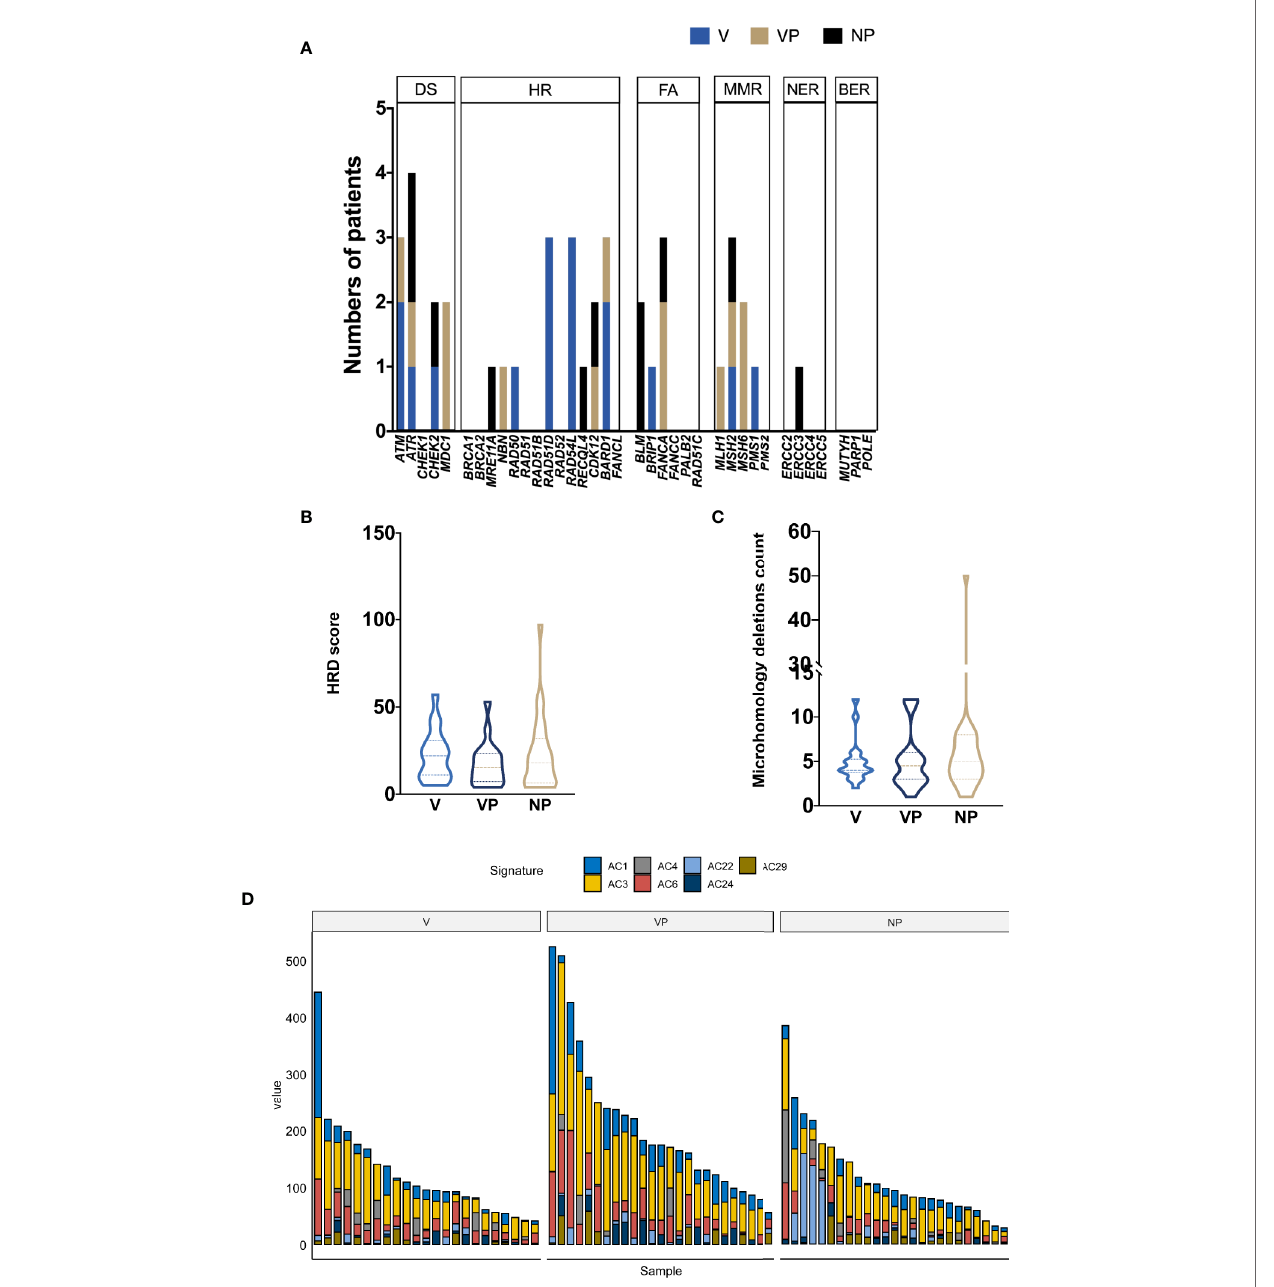
FIGURE 4 | Mutational signature pro fi le and DNA damage repair pathway analysis. (A) The distribution of DDR somatic mutations in each group (V, VP, and NP). The prevalence of HRD score (B) and microhomology deletions (C) . (D) Mutational signature in each group (NP, V, and VP). AC, Alexandrov COSMIC; DS, damage sensor; HR, homologous recombination repair; DDR, DNA damage repair; FA, Fanconi anemia; MMR, mismatch repair; NER, nucleotide excision repair; BER, base excision repair; VTT, venous tumor thrombus; V, VTT; VP, matched primary tumor; NP, normal primary tumors without VTT; HRD, homology recombination de fi